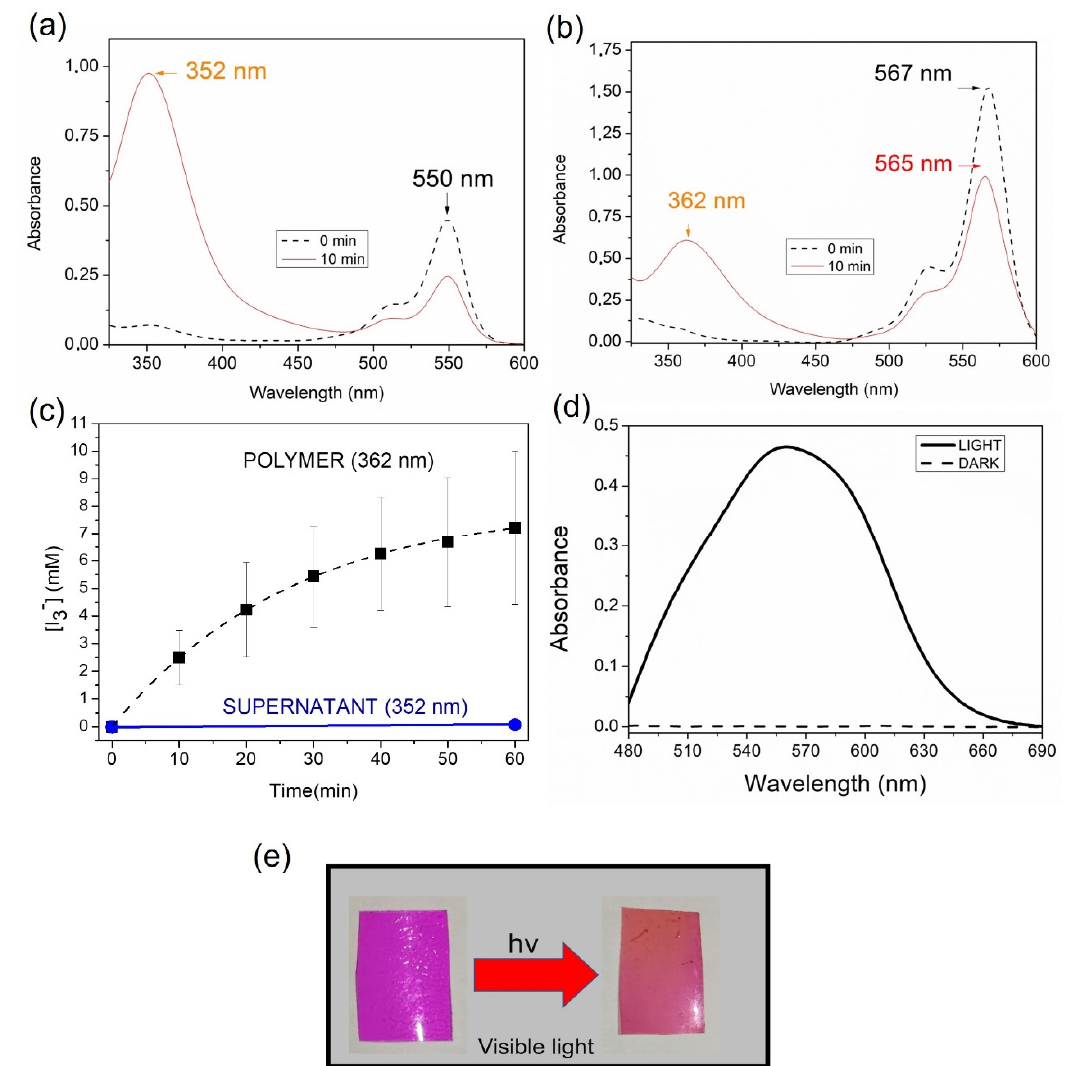
Figure 4. Generation of I 3 − Anion upon Irradiation of ( a ) RB Aqueous Solution (5 μ M) Plus KI (100 mM) and ( b ) Film RB@PHEMA(I). ( c ) Evolution of Concentration of I 3 − in Film RB@PHEMA(I) and Supernatant. ( d ) Detection of H 2 O 2 in the Supernatant by Means of Xylenol Orange Method (See Experimental Section; Case of RB@PHEMA(I) Irradiated for 1 h). ( e ) Pictures of Films of RB@PHEMA(I) Before (left) and After (right) Irradiation.